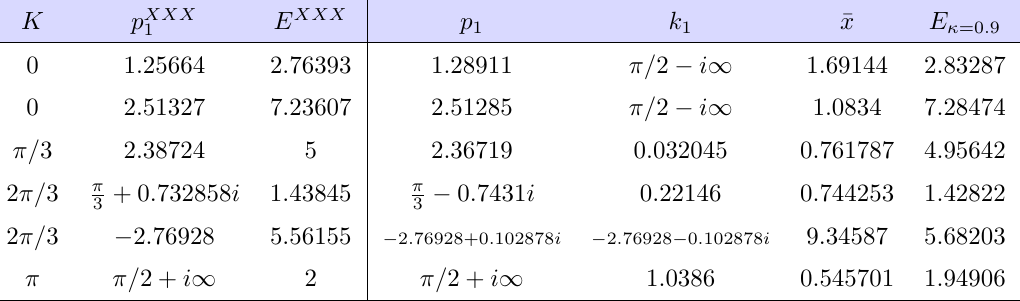
Table 2 . Length-6, κ = 0 . 9 untwisted XY -sector chain: the momenta and energies appearing in the untwisted XY 2-magnon problem for the case L = 6 , κ = 0 . 9 . K is the total momentum. On the left we list the XXX ( κ = 1 ) momenta and energies for comparison. These can be found for instance in [115] (however, note that the XXX limit of our Hamiltonian has an extra factor of 2 compared to the usual XXX normalisation, so our energies are also rescaled by 2 relative to [115]). The p momenta can be found as p = K − p , k = K − k . For the deformed theory we have 2 , k 2 2 1 2 1 chosen the p momenta to be the ones closest to the corresponding momenta for XXX . ¯ x is the ratio between the A and B solutions, as discussed in the text. The energies included here are the “true” 2-magnon energies, i.e. those where both p and p in the XXX limit are 1 2